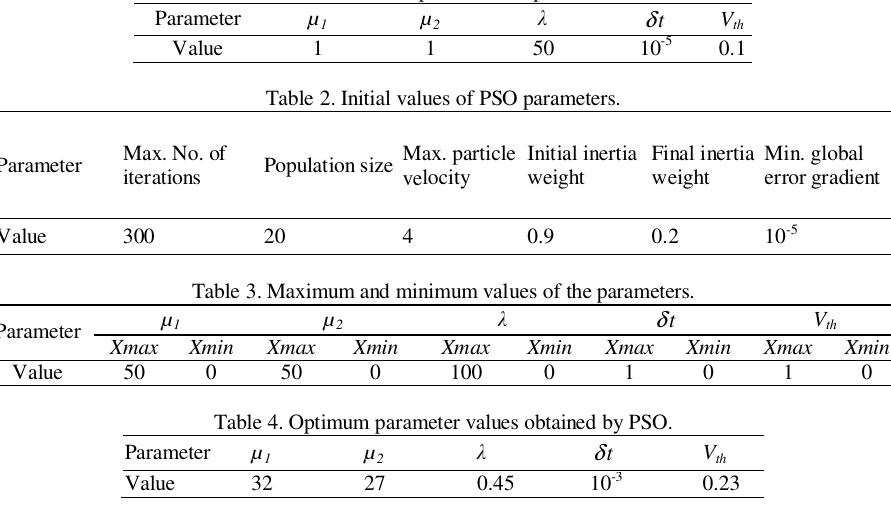
Table 1. Values of HNN parameters reported in Ref. 38.